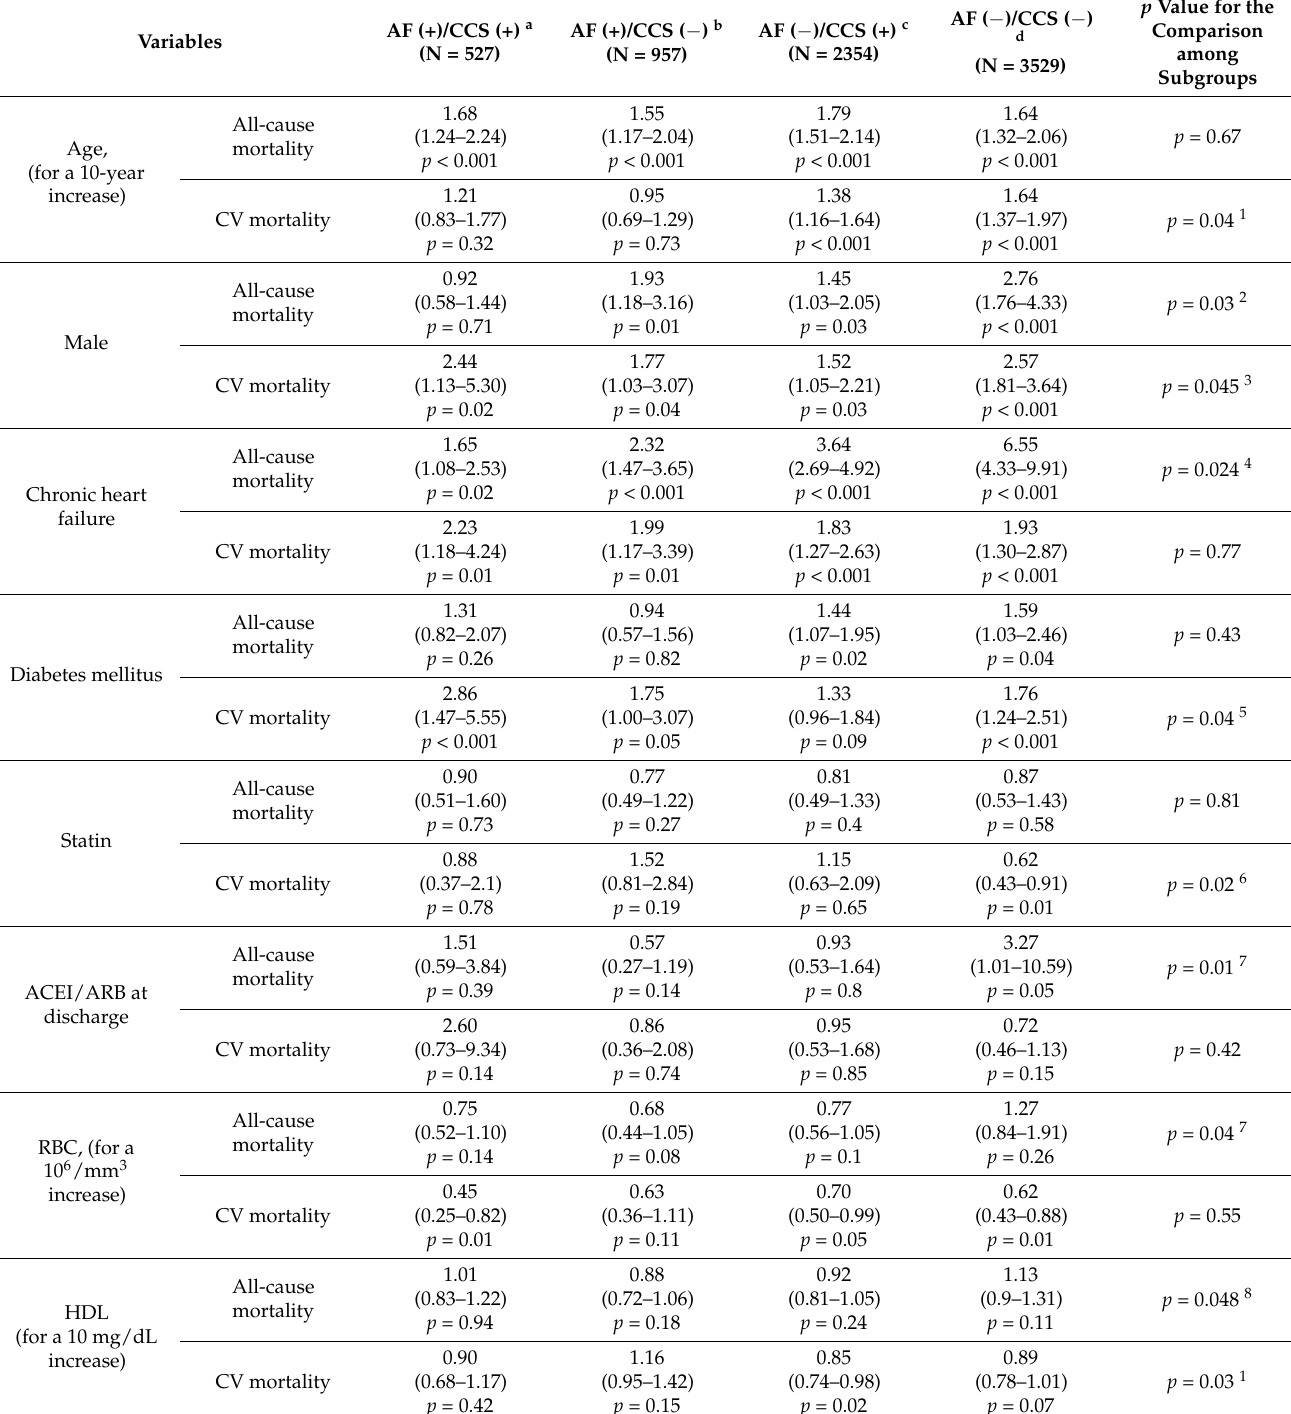
1 significant difference between the b vs. c/d groups. 2 significant differences between the d vs. a/c and a vs. b groups. 3 significant differences between the b vs. c groups. 4 no significant differences between the b vs. a/c groups. 5 significant differences between the a vs. c groups. 6 significant differences between the a vs. b groups. 7 significant differences between the b vs. d groups. 8 significant differences between the d vs. b/c groups. ACEI, angiotensin-converting-enzyme inhibitor; ARB, angiotensin receptor blocker; CV, cardiovascular; HDL, high-density lipoprotein cholesterol; RBC, red blood